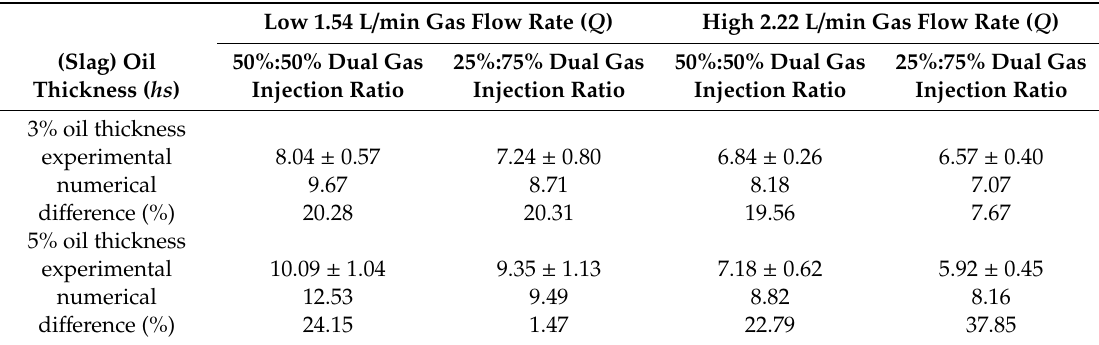
Table 6. Mixing time in seconds for di ff erent operating conditions experimentally (obtained through the planar laser-induced fluorescence (PLIF) method) and compared with the numerical